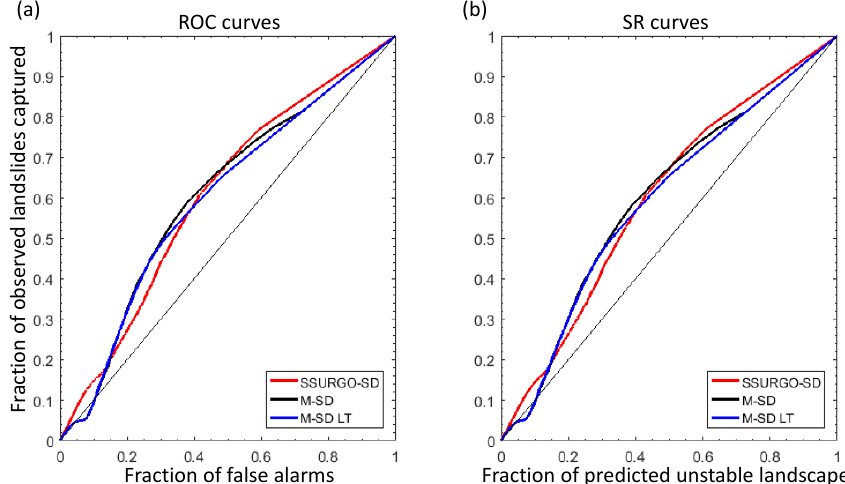
Figure 14. (a) ROC curves and (b) SR curves for simulations using SSURGO-SD, M-SD, and M-SD long term (LT). Comparisons represent P ( F ) for the upper 10% of DA as observed landslides to a random sample of 5000 cells outside DAs. Thresholds for simulated probabilities associated with the positive classification of source areas decline along the curves from the lower left to upper right. Black diagonal line on a 1:1 line represents the case of a trivial or random classification model. AUC values range from 0.60 to 0.61.